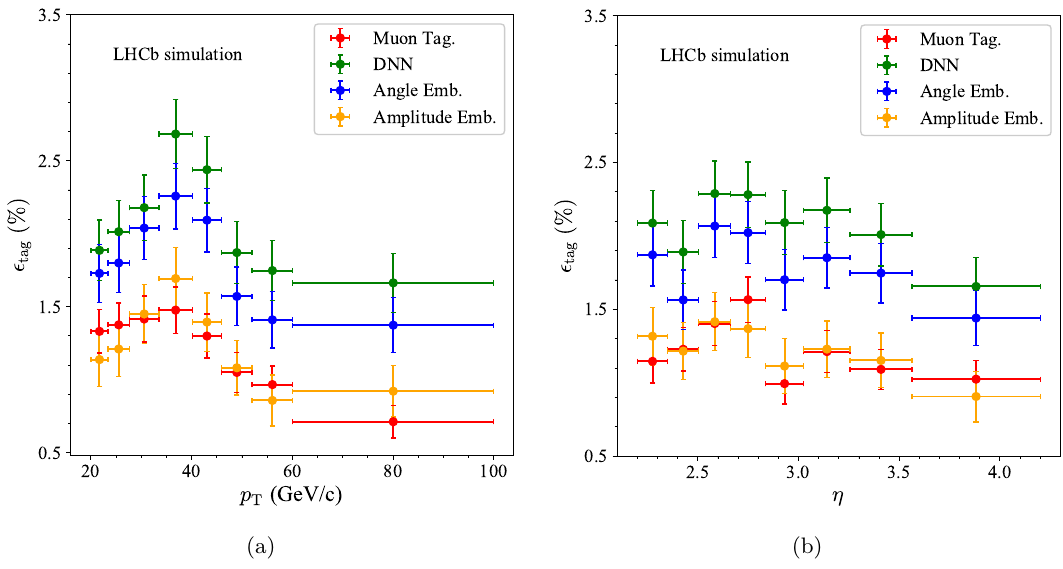
Figure 16. Unoptimised tagging power (cid:15) tag with respect to (a) jet p T and (b) jet η for the muon dataset. The angle embedding circuit and the DNN show similar